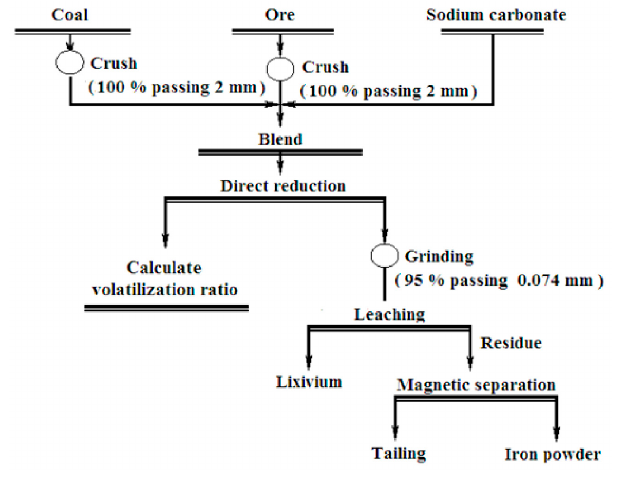
Figure 3. Experiment flow chat.